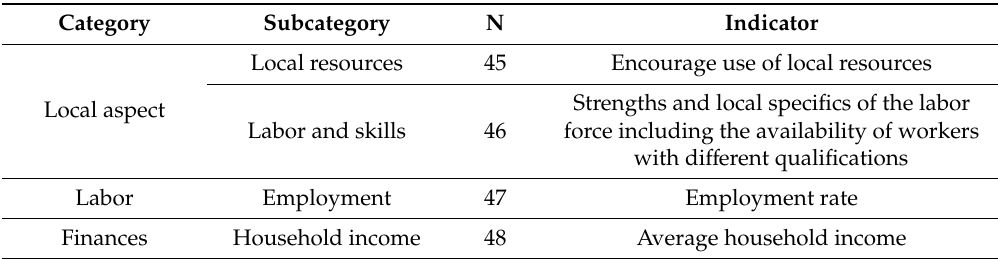
Table 7. Proposed indicators for economic